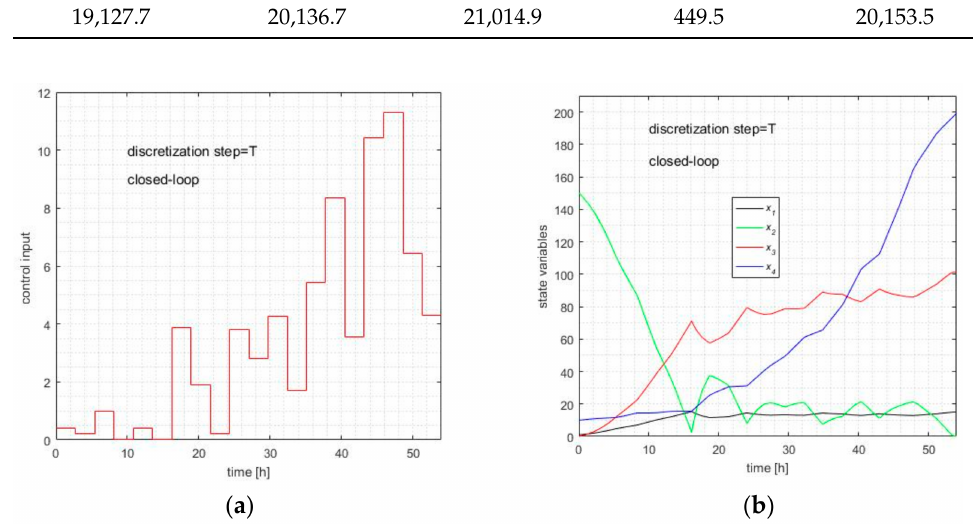
Figure 4. The typical solution given by the Controller using EAv1. ( a ) The quasi-optimal solution given by the Controller using EA. ( b ) State evolution in closed